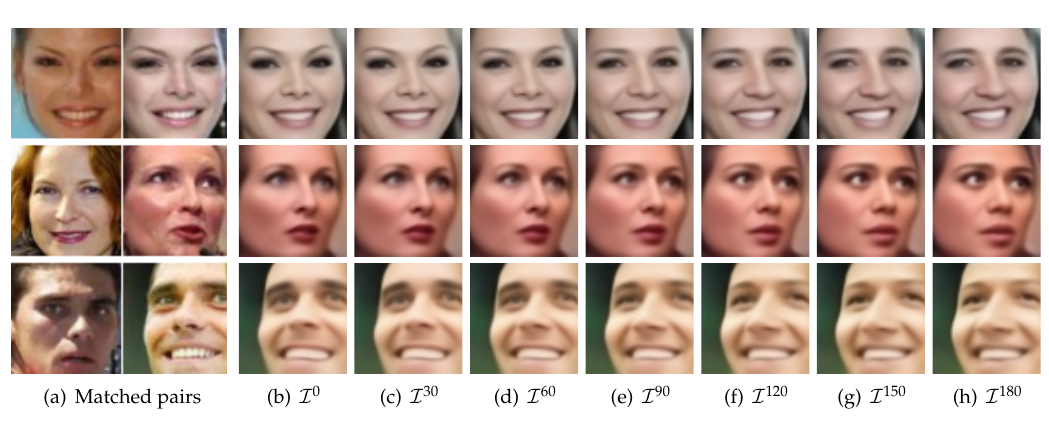
Figure 5. Examples for evaluation on de-identification. ( a ) shows matched pairs from LFW [58], ( b – h ) show de-identified images of the right image on each matched pair rotated by {0, 30, 60, 90, 120, 150, 180} degrees, respectively.